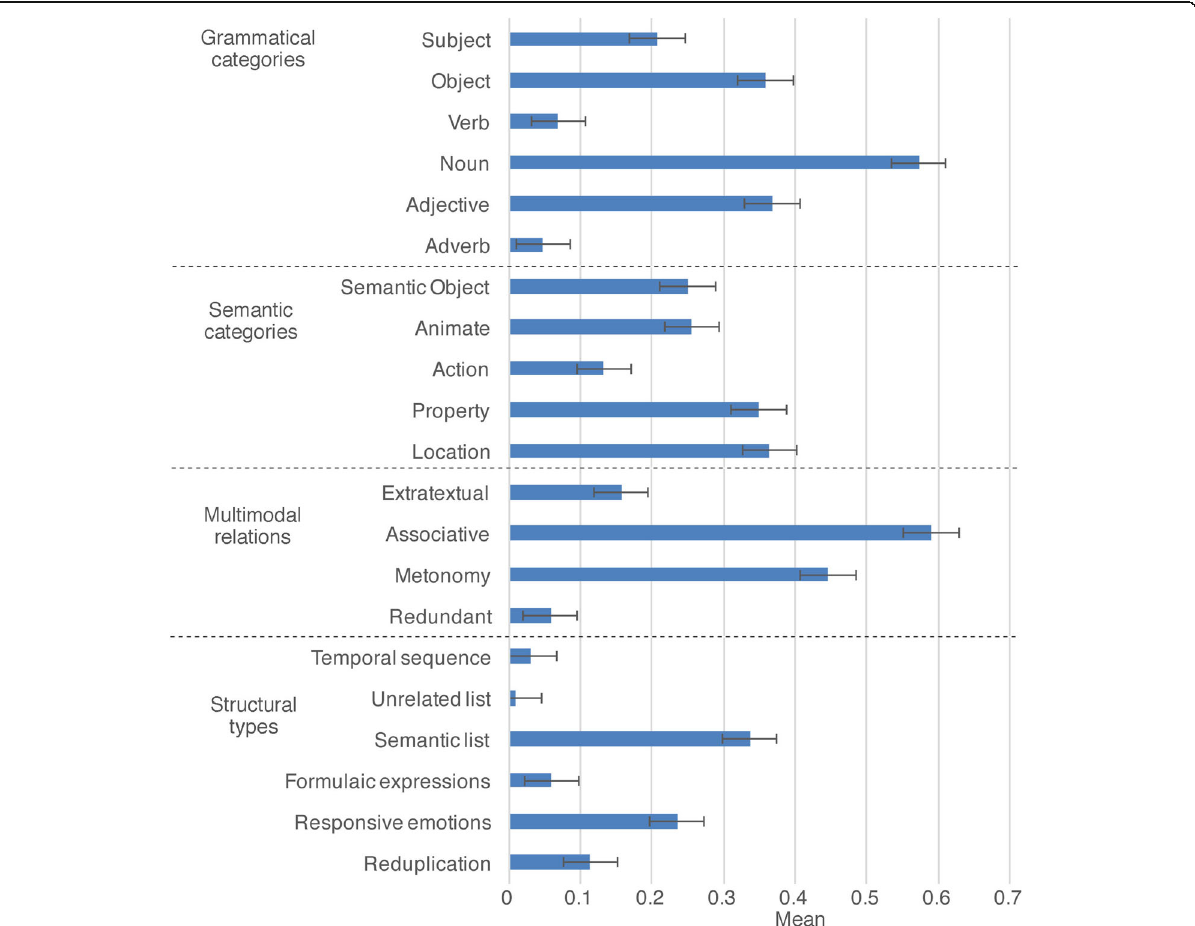
Fig. 4 Characteristics of multimodal interactions between emoji and text, primarily those substituted into sentences for words. Error bars depict standard